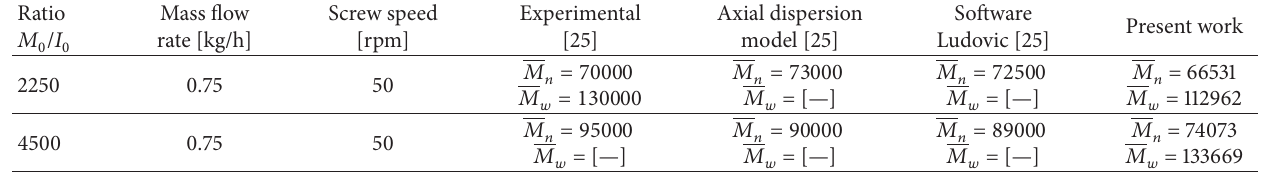
Table 3: Experimental and predicted 𝑀 𝑛 and 𝑀 𝑤 at the extruder exit using SnOct 2 /TPP.